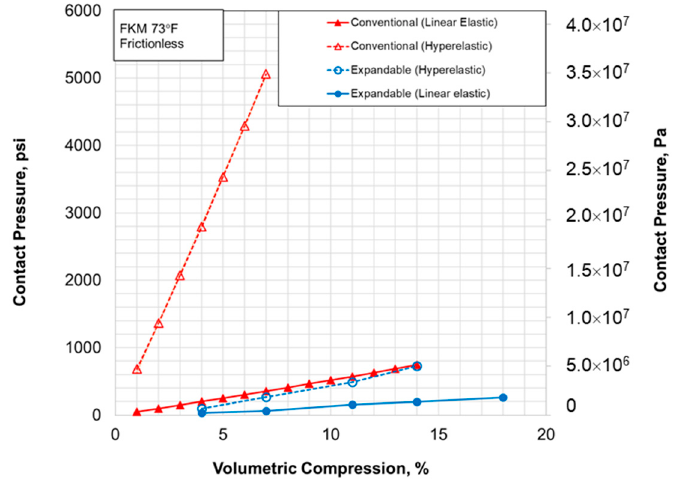
Figure 15. Contact pressure as a function of volumetric compression for conventional and expandable assembly with linear- and hyper-elastic material behavior.